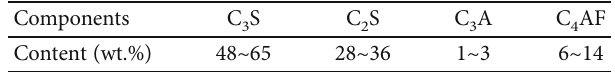
Table 2: Mineral composition of grade G oil-well cement.